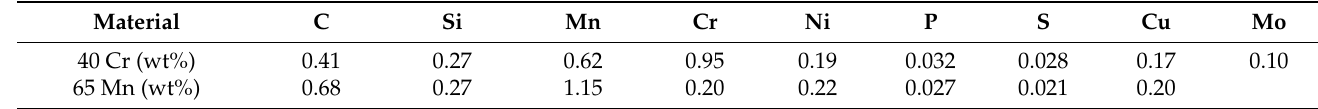
Table 1. The chemical composition of 40 Cr and 65 Mn